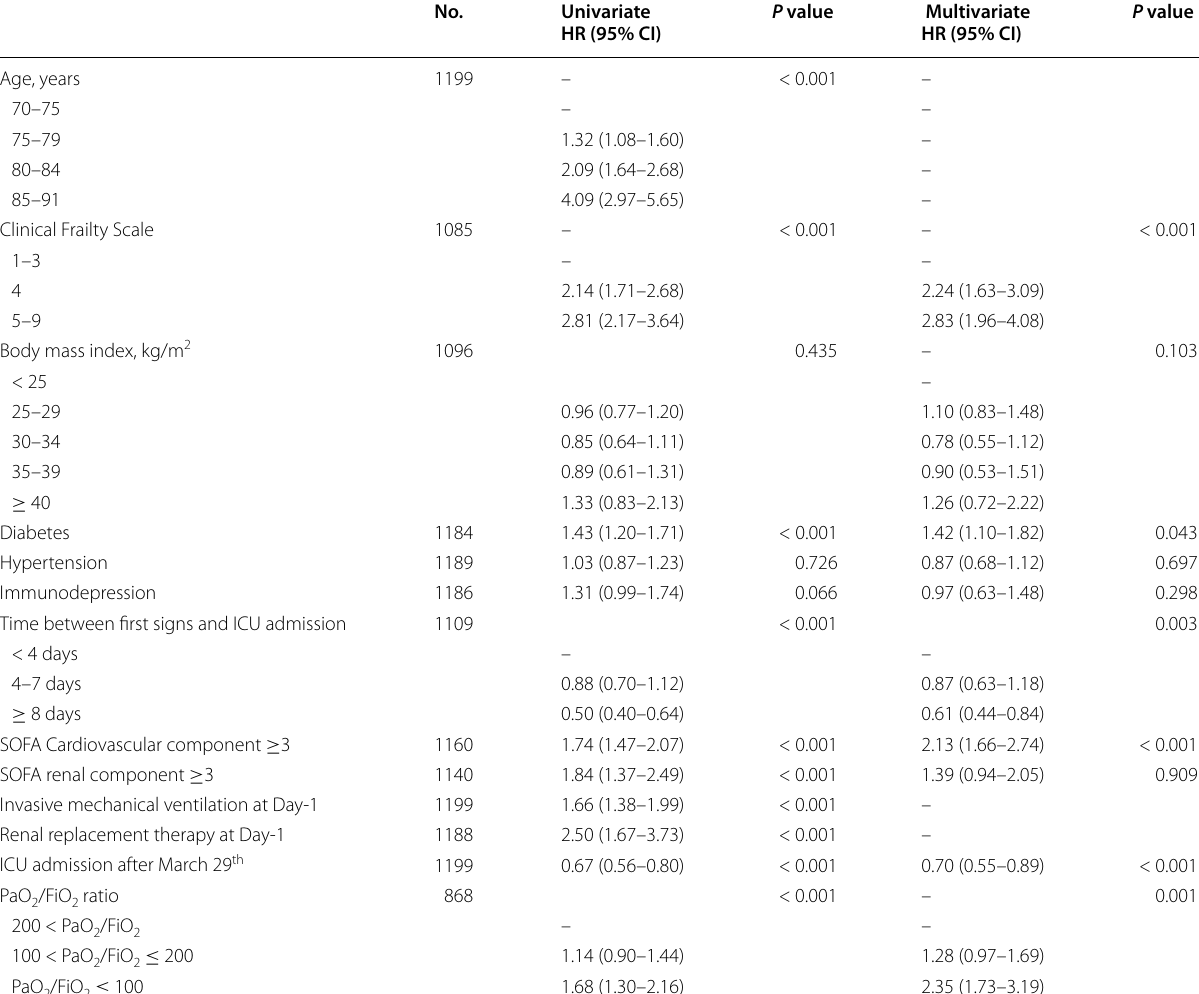
stratified on the center